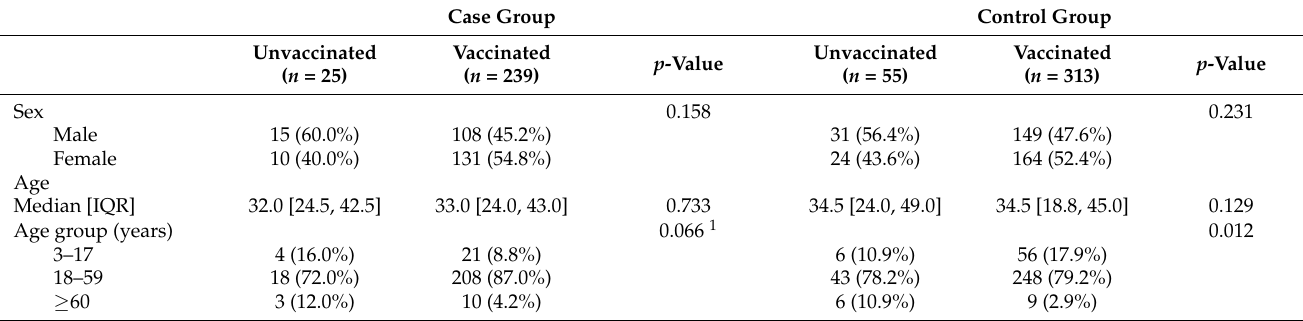
Table 2. Demographic characteristics of the case group ( n = 264) and the control group ( n = 368).